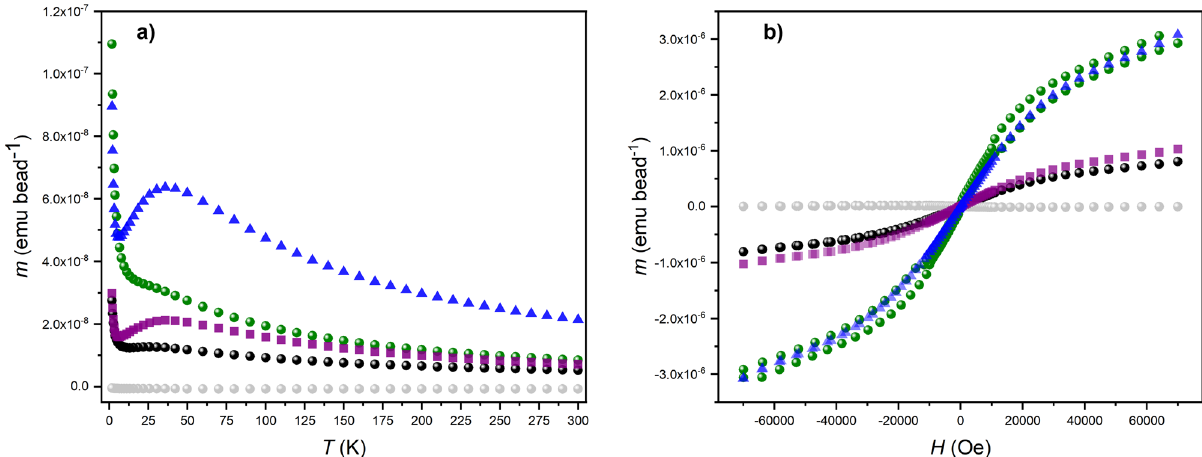
Fig. 5 Magnetic properties of decorated beads. a Variable temperature moment ( m ) at 1000Oe for beads scaled to one bead: 5 (grey), 7 (black), 11 (green), 12 calculated with 1 × 10 14 rotaxanes (purple squares), 12 calculated with 3 × 10 14 rotaxanes (blue triangles). b Variable fi eld moment ( m ) at 2 K for beads scaled to one bead: 5 (grey), 7 (black), 11 (green), 12 calculated with 1 × 10 14 rotaxanes (purple squares), 12 calculated with 3 × 10 14 rotaxanes (blue